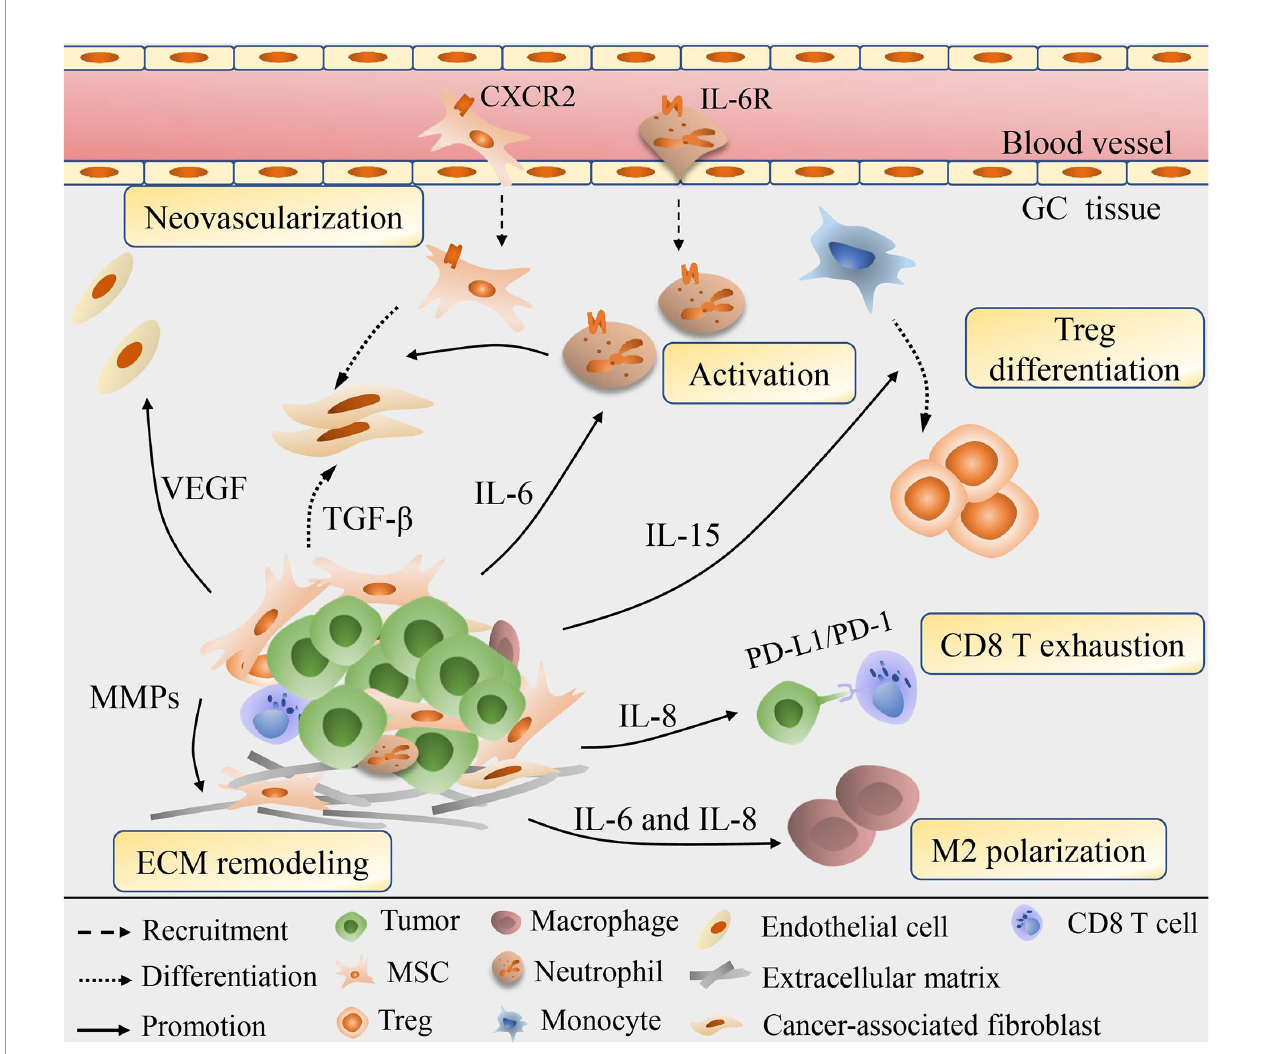
FIGURE 2 | Schematic diagram for the role of MSC in the remodeling of GC stroma. MSC could be recruited into cancer stroma and are involved in the continuous updating and transformation of stroma components. Via secretion of various cytokines, e.g., IL-6, IL-8, IL-15, MSC modulate the Treg differentiation, macrophage polarization, neutrophil recruitment and activation, exhaustion of CD8 T cells, thus offering local immune-suppressive milieu. MSC could also secret VEGF and MMPs to induce neovascularization and ECM degrading, or directly differentiate into CAF to exhibit synergistic effect in remodeling cancer cells and